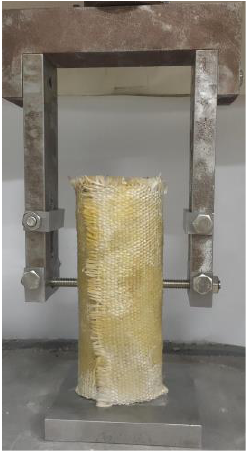
Figure 2. Physical diagram of D100-1/2H-M10-1.